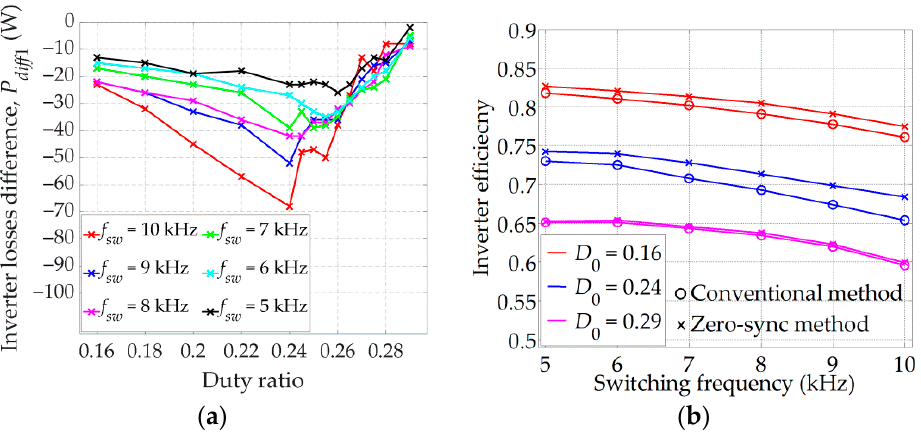
Figure 14. Inverter losses difference ( P diff 1 ) as a function of the duty ratio for different switching frequencies ( a ); inverter efficiency as a function of the switching frequency for different duty ratio values ( b ).